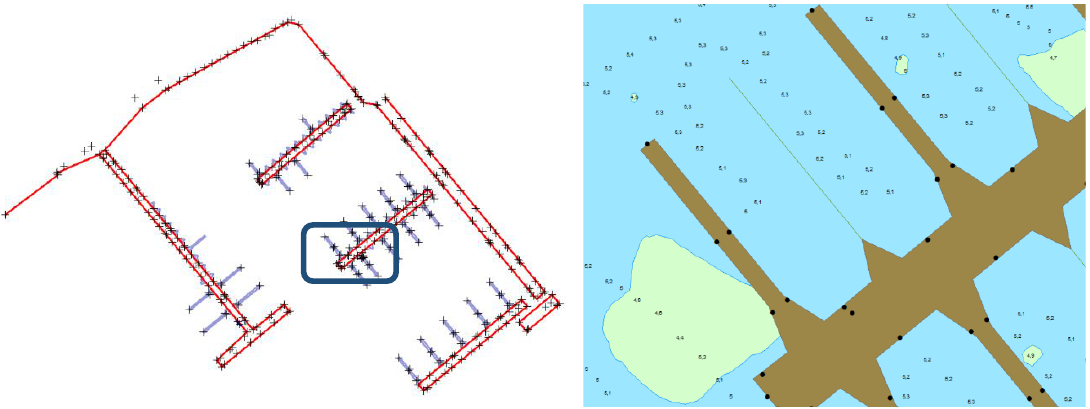
Figure 4. A sketch of geodetic surveys (on the left) and field surveys plotted on ENC.